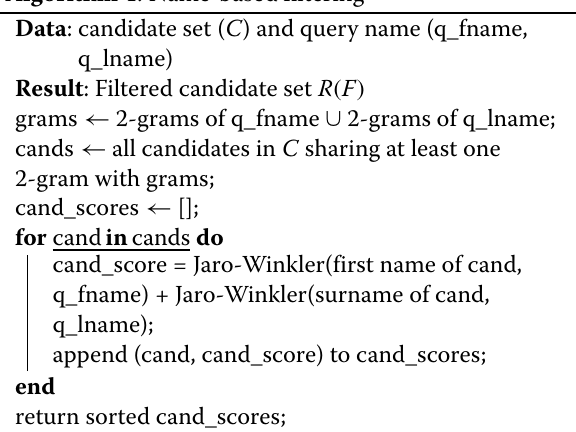
Algorithm 4: Name-based filtering